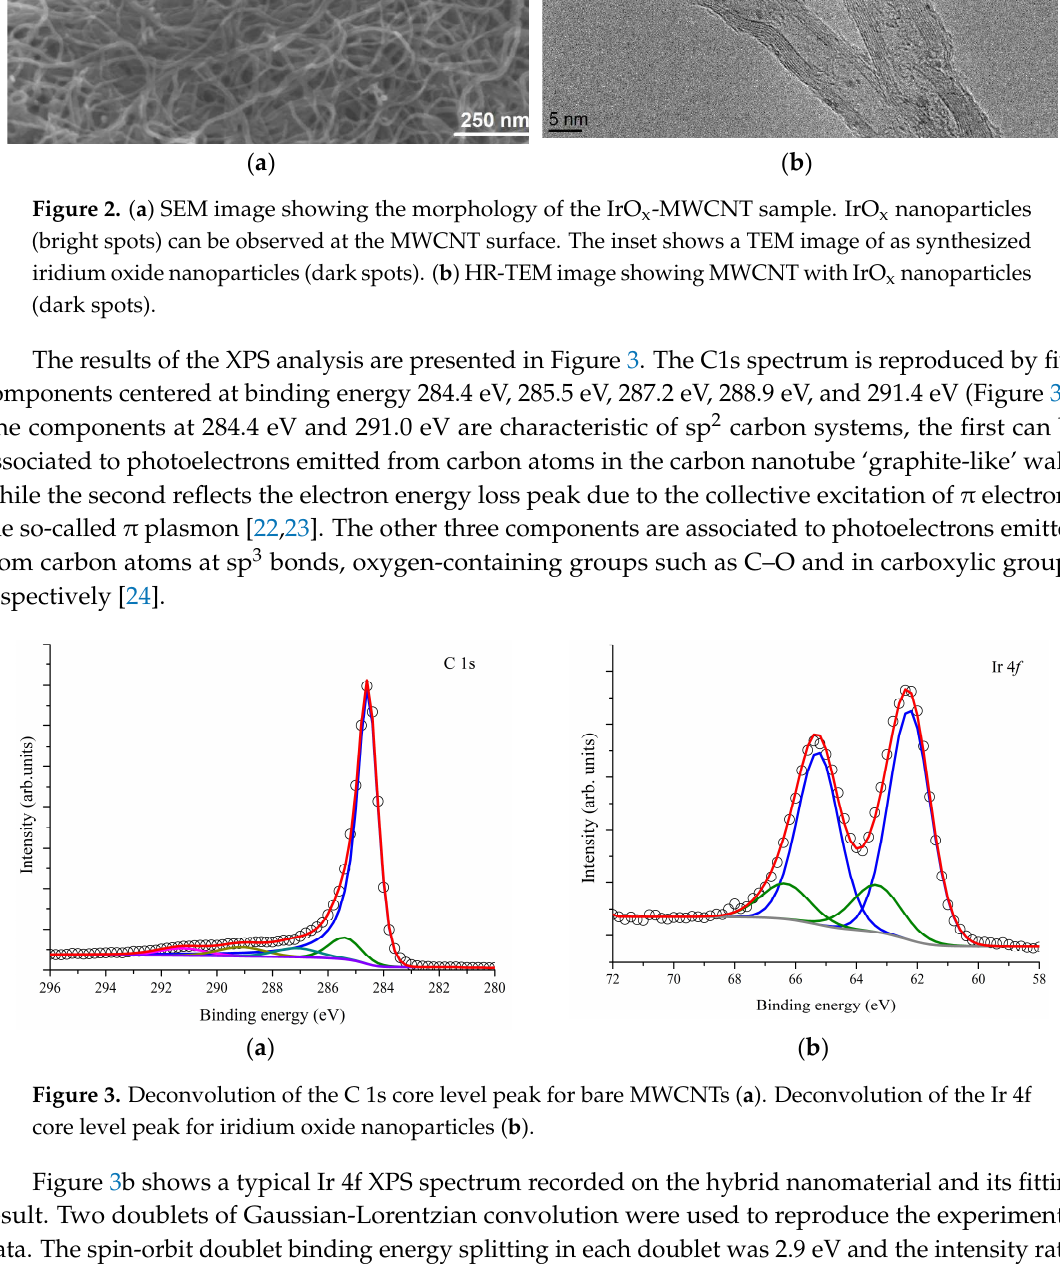
Figure 2. ( a ) SEM image showing the morphology of the IrO x -MWCNT sample. IrO x nanoparticles (bright spots) can be observed at the MWCNT surface. The inset shows a TEM image of as synthesized iridium oxide nanoparticles (dark spots). ( b ) HR-TEM image showing MWCNT with IrO x nanoparticles (dark spots).